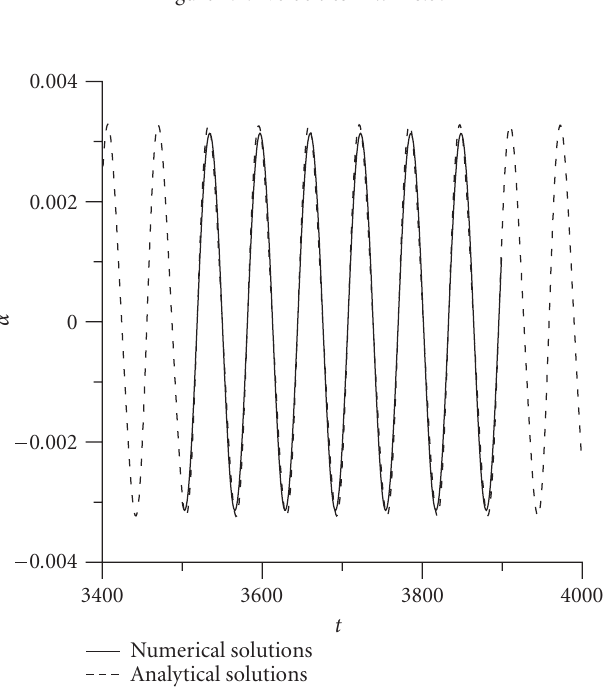
Figure 4.4. Velocities in x = 0 . 5.